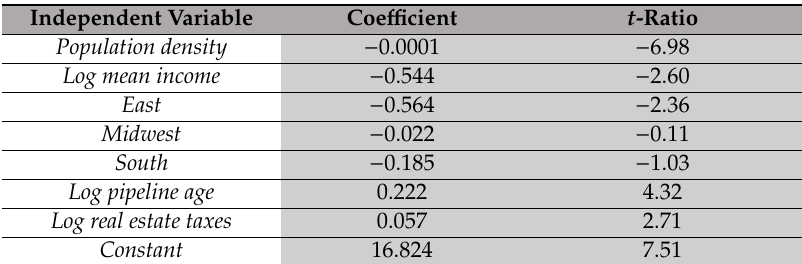
Table 4. Regression results (dependent variable: Cost of